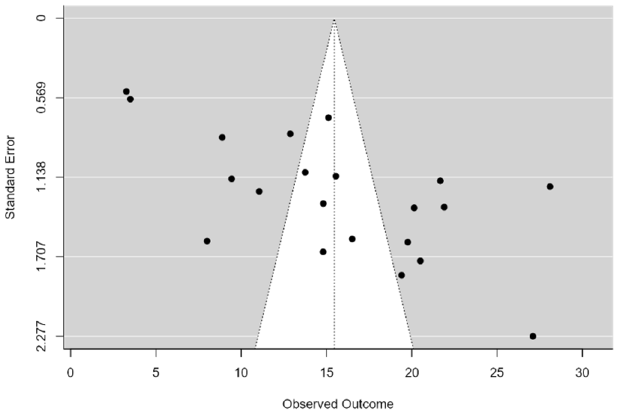
Figure 4. Funnel plot for publication bias.